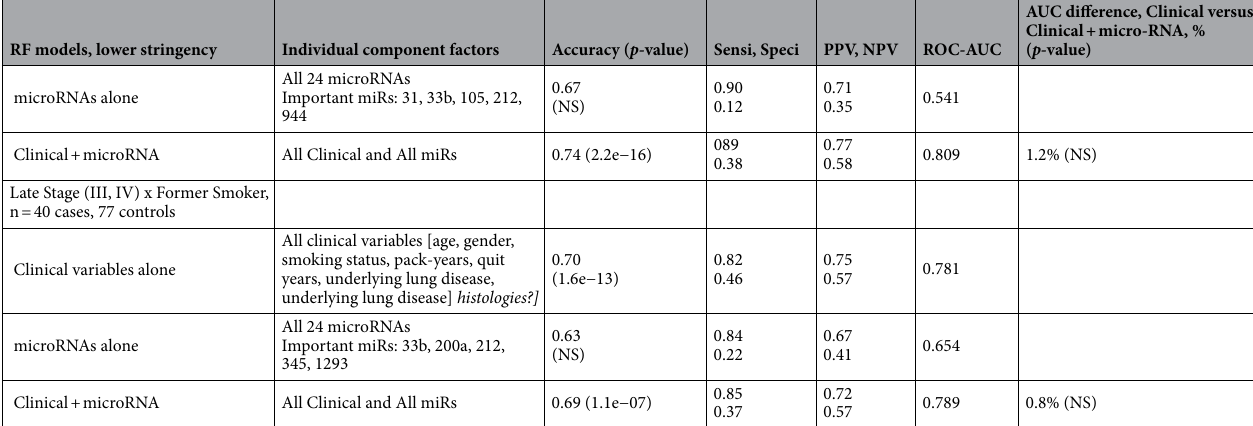
Table 4. Exhaled microRNA RF models. RF Models of case–control distinction, including clinical variables alone, exhaled microRNAs alone, and the two combined, and performance characteristics of accuracy, sensitivity, specificity, positive and negative predictive value (PPV, NPV, resp.), Underlying lung disease is treated as a (trichotomous) variable: (3). COPD or fibrosis or inflammation or asthma (all carry some lung cancer risk); versus (2). sarcoid bronchiectasis; versus (1)